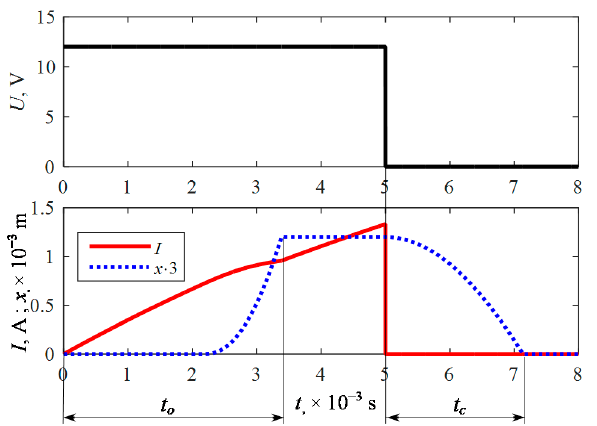
Figure 6. Variations of voltage, current in coil and plunger displacement were obtained by calculation at x max = 0.4 × 10 − 3 m.